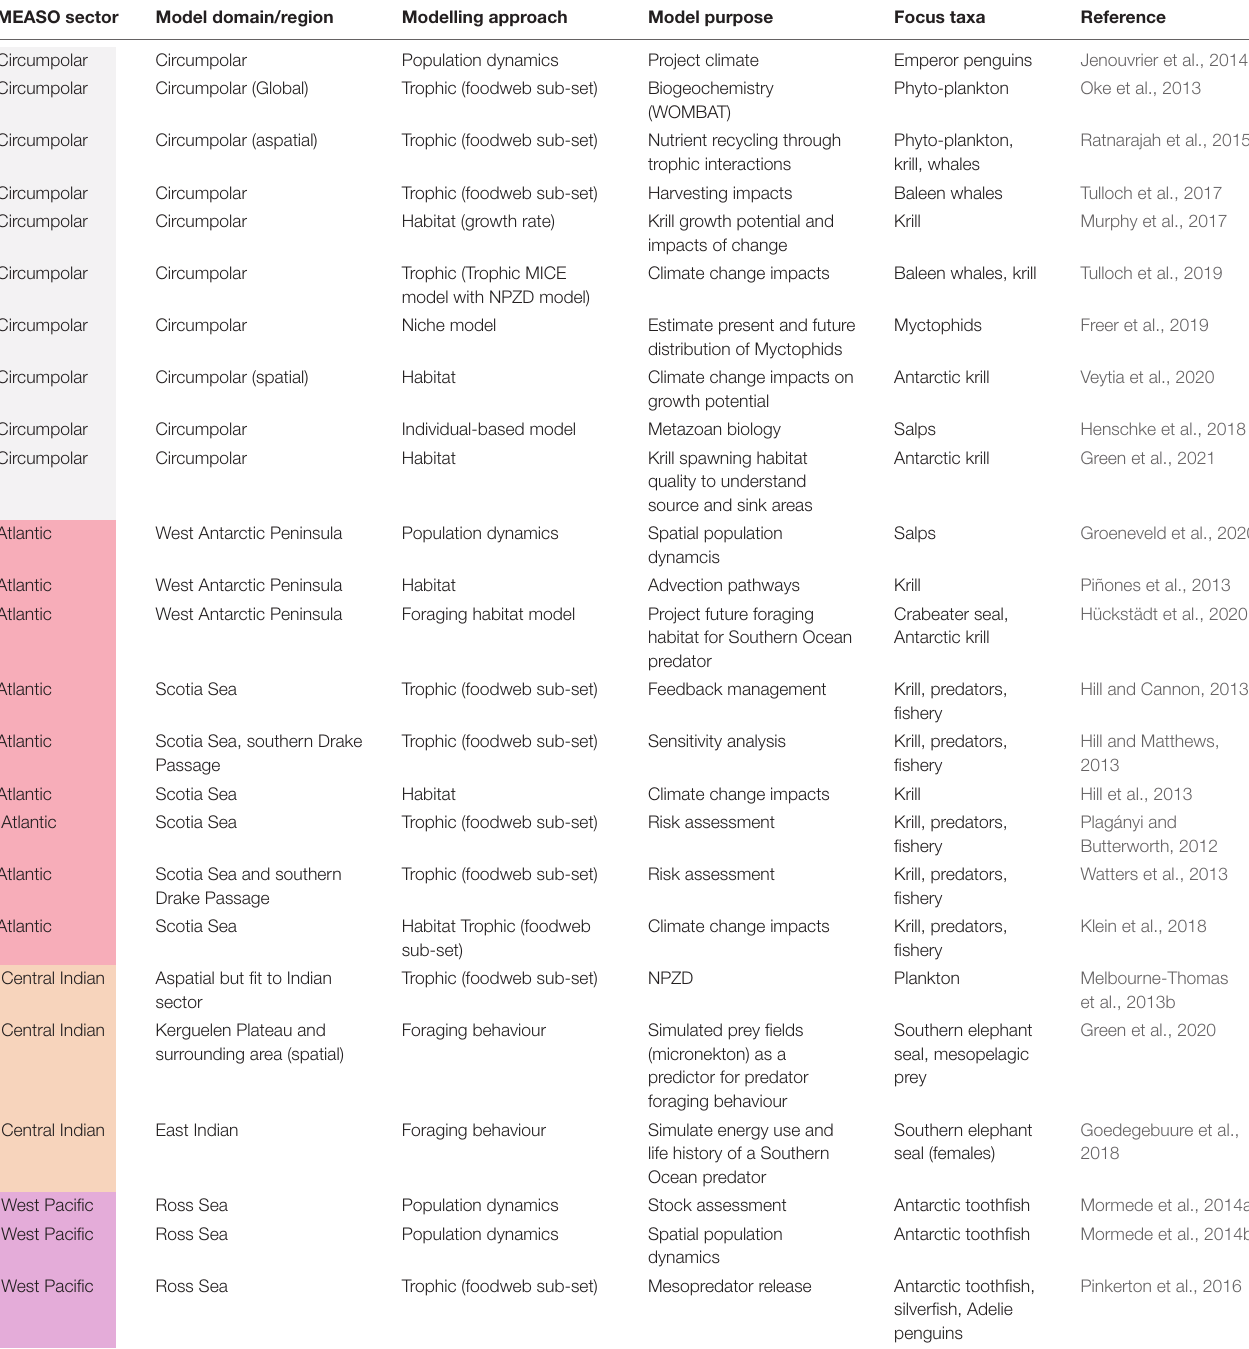
TABLE 2 | Examples of published models (since 2012) for the Southern Ocean which capture habitat, population and trophic interactions for key species (not fully comprehensive). MEASO